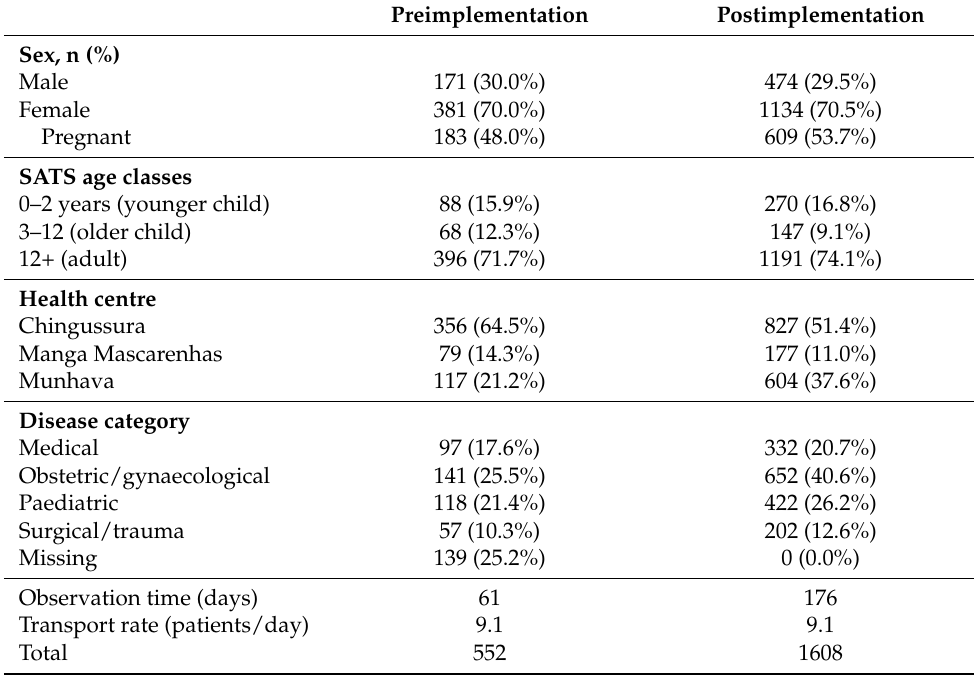
Table 1. Demographic information of referred patients before and after SATS